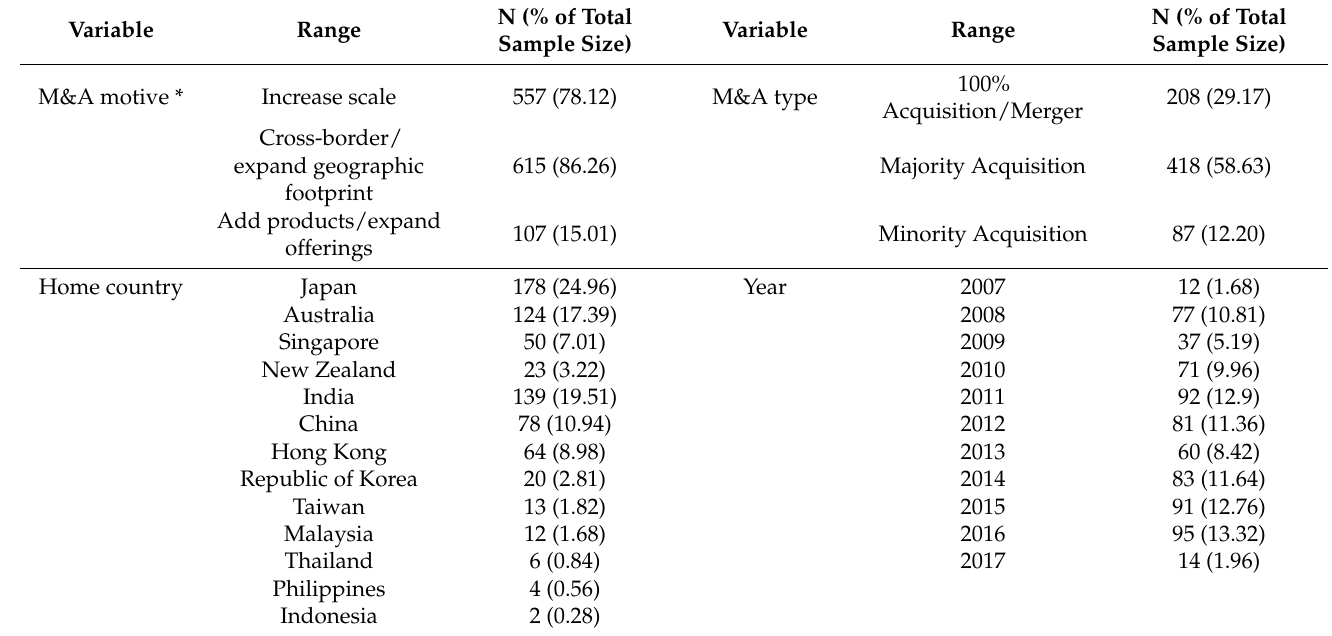
Figure A3. Proportion of M&A deals with the three main motives by year. Note: Only results for top three motives cited in Marketline Advantage database are used. Emerging and Developed (Japan, Australia, New Zealand, and Singapore) market classifications are based on Morgan Stanley Capital International definitions, although Hong Kong has been classified as Emerging due to regulatory influences from China. Other emerging markets (acquirer home countries) included in our analysis are: India, China, Republic of Korea, Taiwan, Malaysia, Thailand, Philippines, and Indonesia. Table A1. Sample information (N = 713).